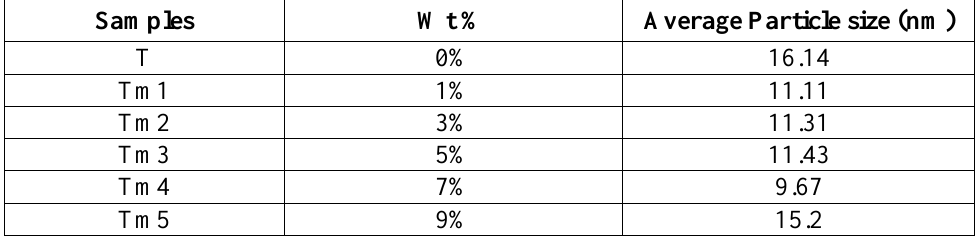
Fig.4: SEM images of Mn-doped TiO Table 2: Summary of the data obtained by SEM analysis on the TiO and Mn-doped TiO